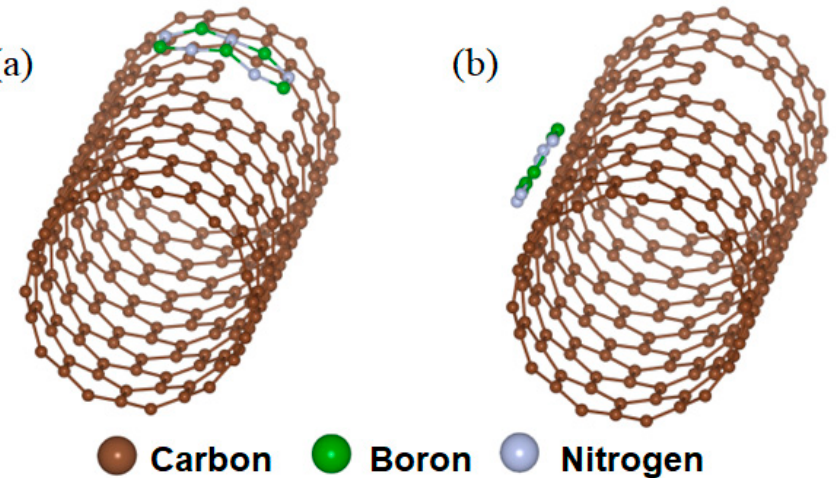
Figure 4. First-principles calculations of BN adsorption on the wall of SWCNTs ( a ) with defects and ( b ) without defects.